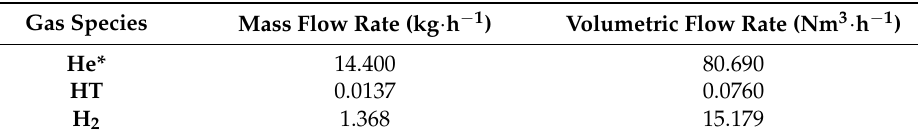
Table 2. Membrane diffuser feed flow rates.